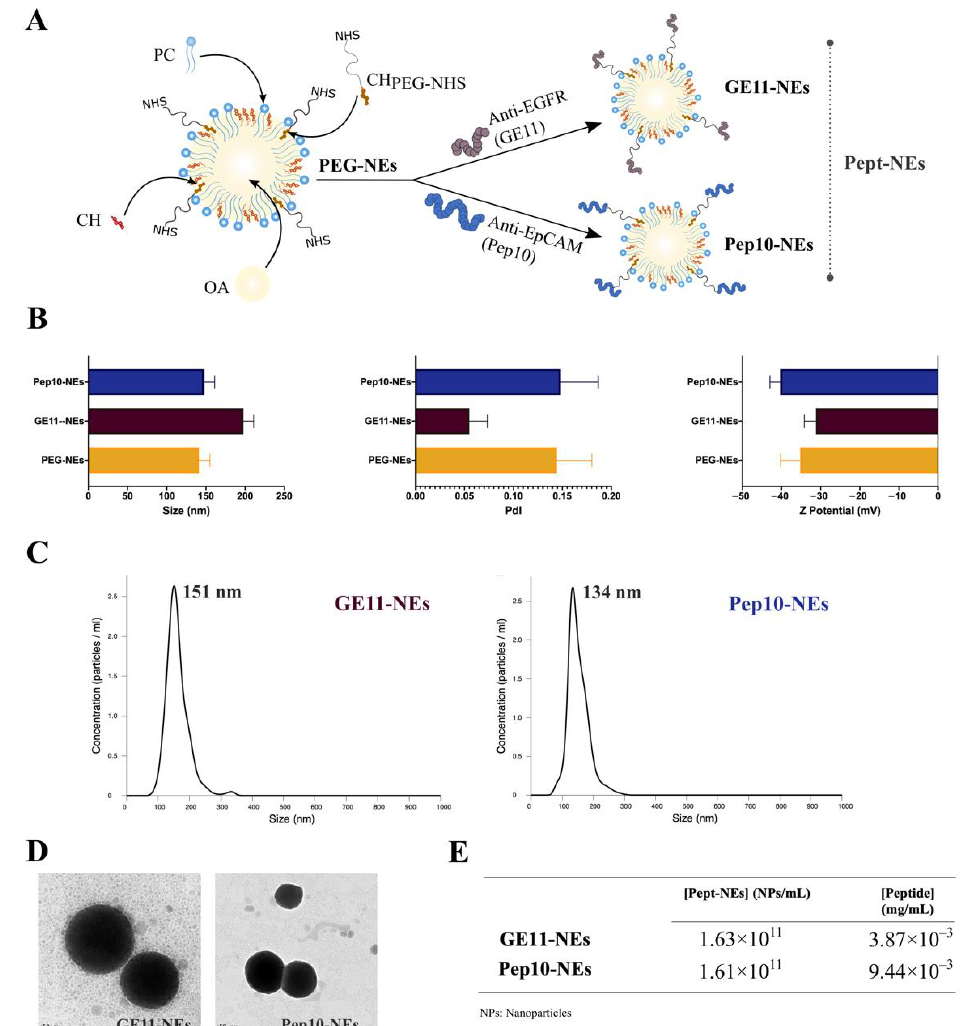
Figure 3. Characterization of PEG-NEs, GE11-NEs, and Pep10-NEs. ( A ) Scheme for the formulation of PEG-NEs made of phosphatidylcholine (PC), cholesterol (CH), oleic a(OA), and cholesterol-PEG with N-HydroxySuccinimide ester-PEG modification (CH PEG-NHS ) and the association of peptides to obtain Pept-NEs (GE11-NEs and Pep10-NEs). ( B ) Hydrodynamic size (nm), polydispersity index (PdI), and ζ -Potential (mV) measurements. Values represent mean ± SD ( n = 10). ( C ) Sizes of Pept- NEs as determined by Nanoparticle Tracking Analysis (NTA). ( D ) TEM images of GE11-NEs and Pep10-Nes. ( E ) I Pept-NEs concentrations (NPs/mL) and concentrations of the peptides in 1 mL formulation (mg/mL).